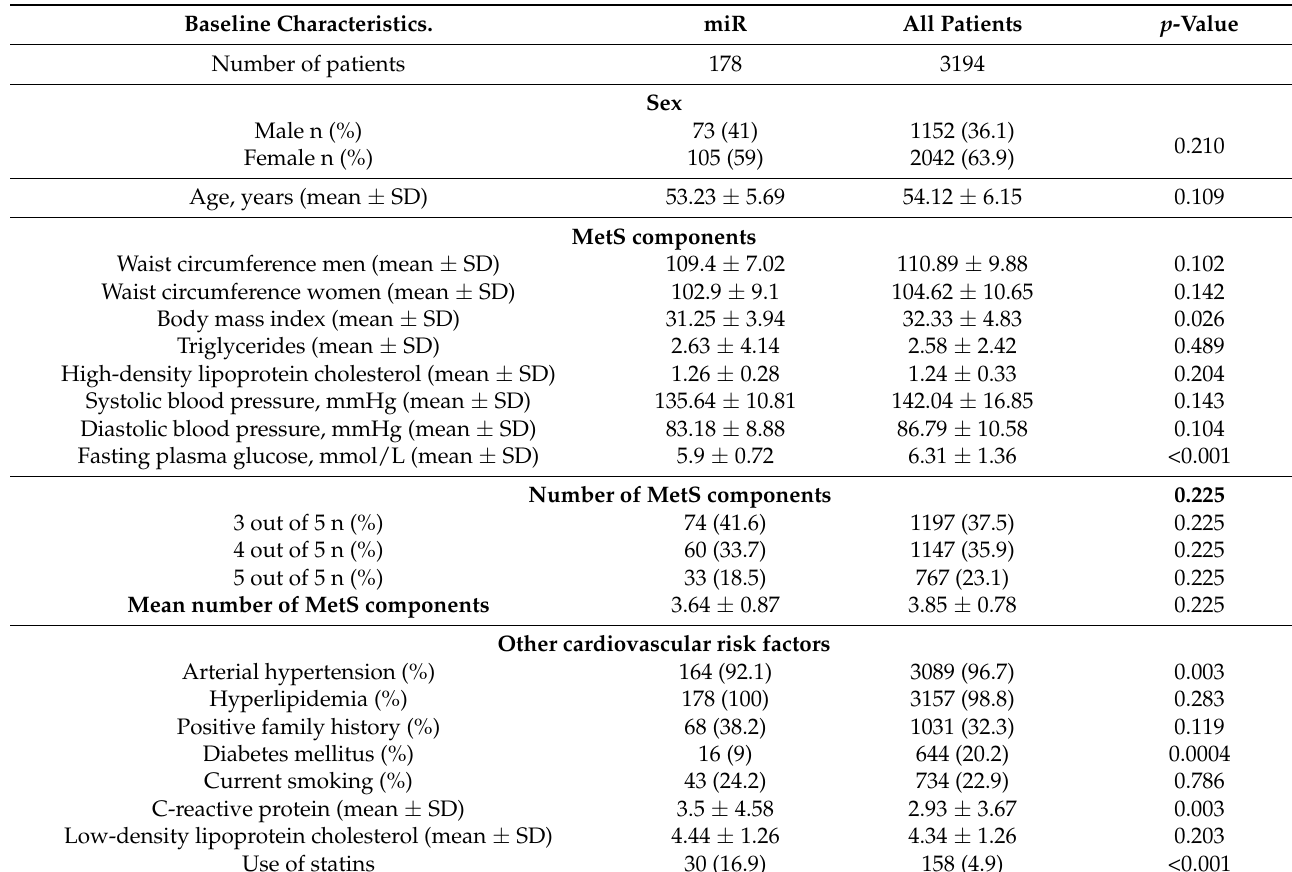
Table 1. Baseline characteristics.